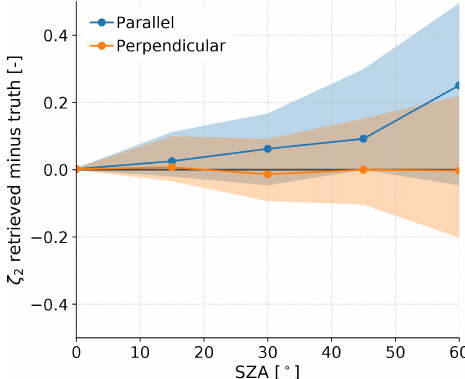
Figure 7. Median and 5%–95% range of retrieved minus true ζ 2 as a function of solar zenith angle. “Parallel” refers to calculation along the solar azimuth direction, and “Perpendicular” refers to cal- culation perpendicular to